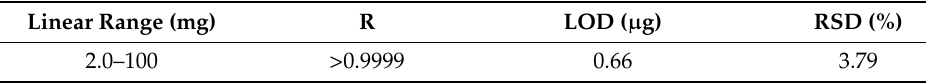
Table 2. N content analytical performance of the instrument.